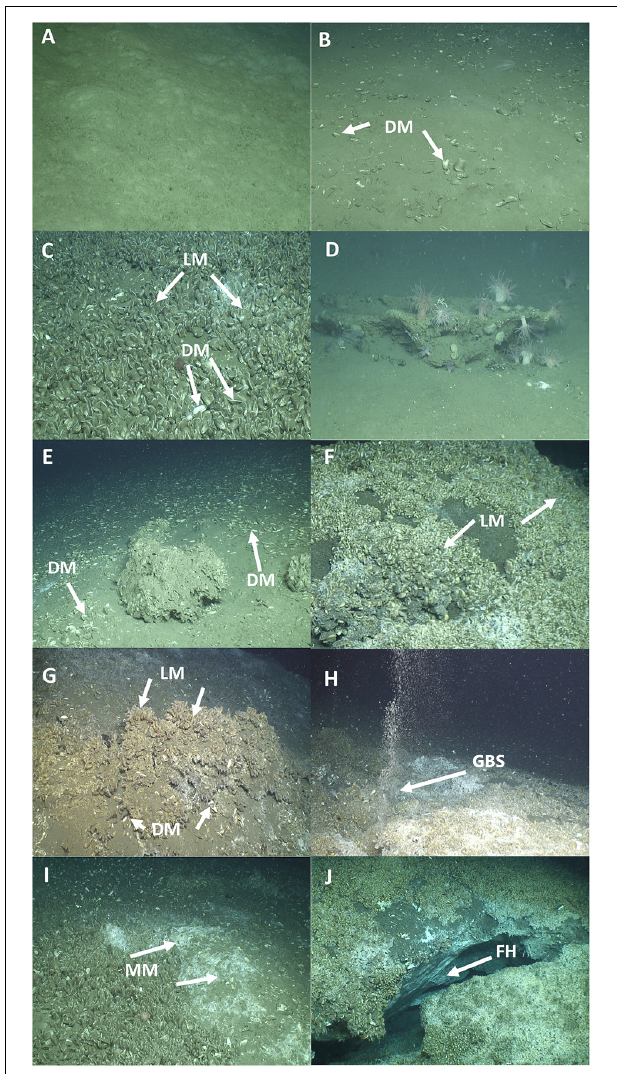
FIGURE 2 | Types of habitats, gas bubbling sites, and microbial mats. (A) Sand-mud; (B) sand with dead mussels (DM); (C) sand with dead and live mussels (LM); (D) mixed hard-soft; (E) mixed hard-soft with dead mussels; (F) mixed hard-soft with live mussels; (G) mixed hard-soft with dead and live mussels; (H) presence of gas bubbling site (GBS); (I) presence of microbial mat (MM); (J) frozen hydrate (FH).